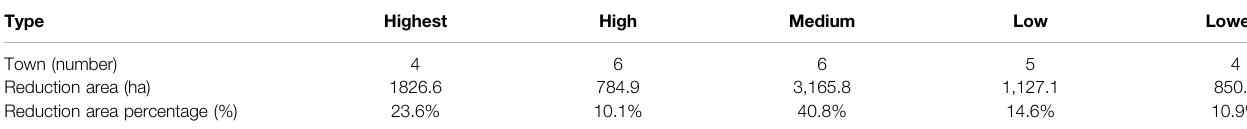
TABLE 2 | Reduction of rural settlement areas among towns in Pudong.